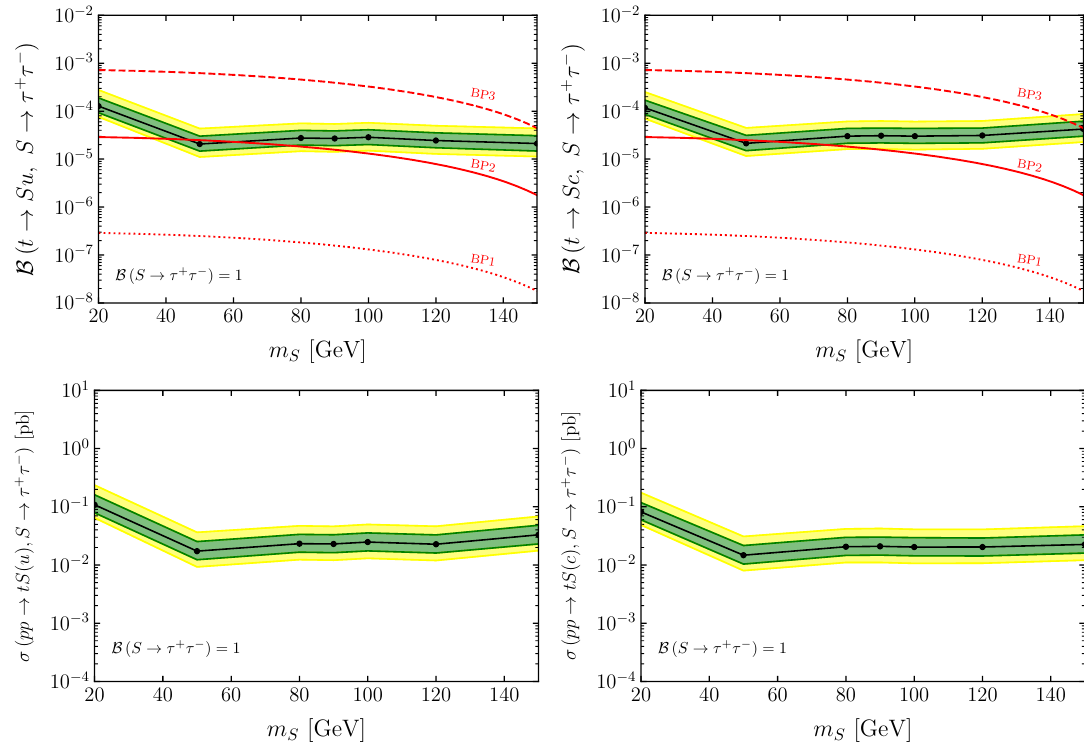
Figure 6 . In the upper (bottom) panels, we show the 95% CL limits on the branching ratio (cross section times branching ratio) that can be tested in the (cid:28) + (cid:28) (cid:0) channel, in the analysis proposed for t ! Sq; S ! (cid:28) + (cid:28) (cid:0) , with q = u ( c ) in the panels on the left (right). The green and yellow bands show the (cid:6) 1 (cid:27) and (cid:6) 2 (cid:27) uncertainty on the limits, respectively. The limits are obtained for a collected luminosity L = 150 fb (cid:0) 1 . Superimposed are the theoretical expectations in three